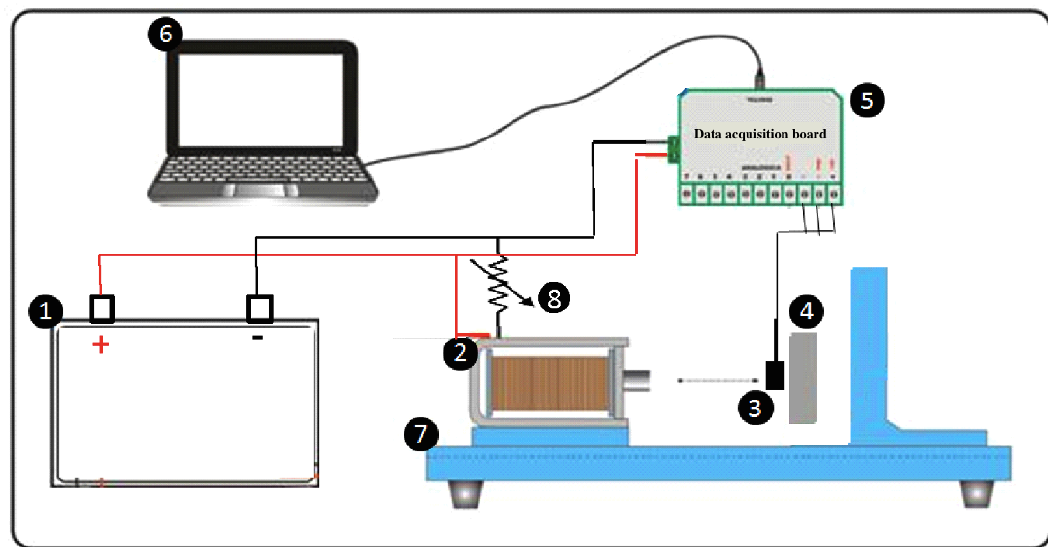
Figure 1. Experimental setup: ( 1 ) power supply; ( 2 ) solenoid; ( 3 ) Hall sensor; ( 4 ) sample; ( 5 ) data acquisition board; ( 6 ) computer; ( 7 ) bench test and ( 8 )